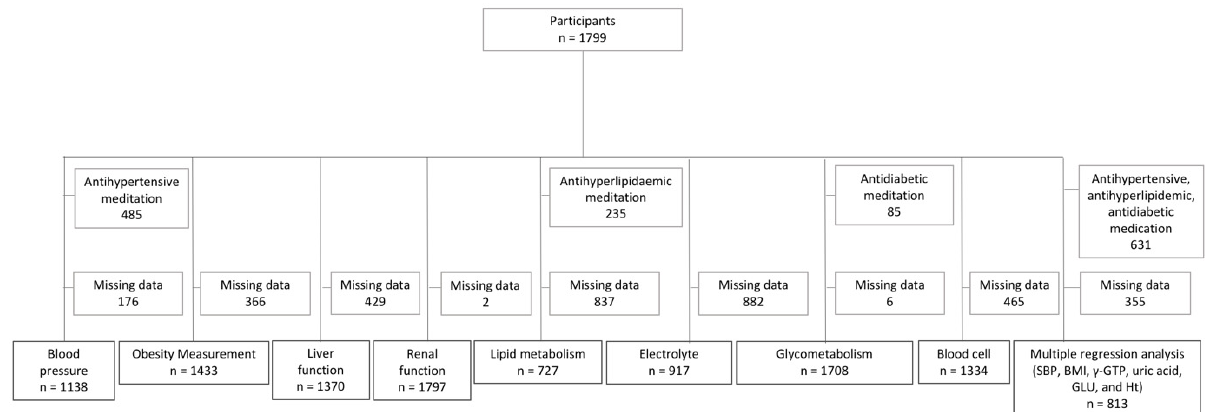
seven subgroups and the multiple regression analysis. SBP—systolic blood pressure; BMI—Body